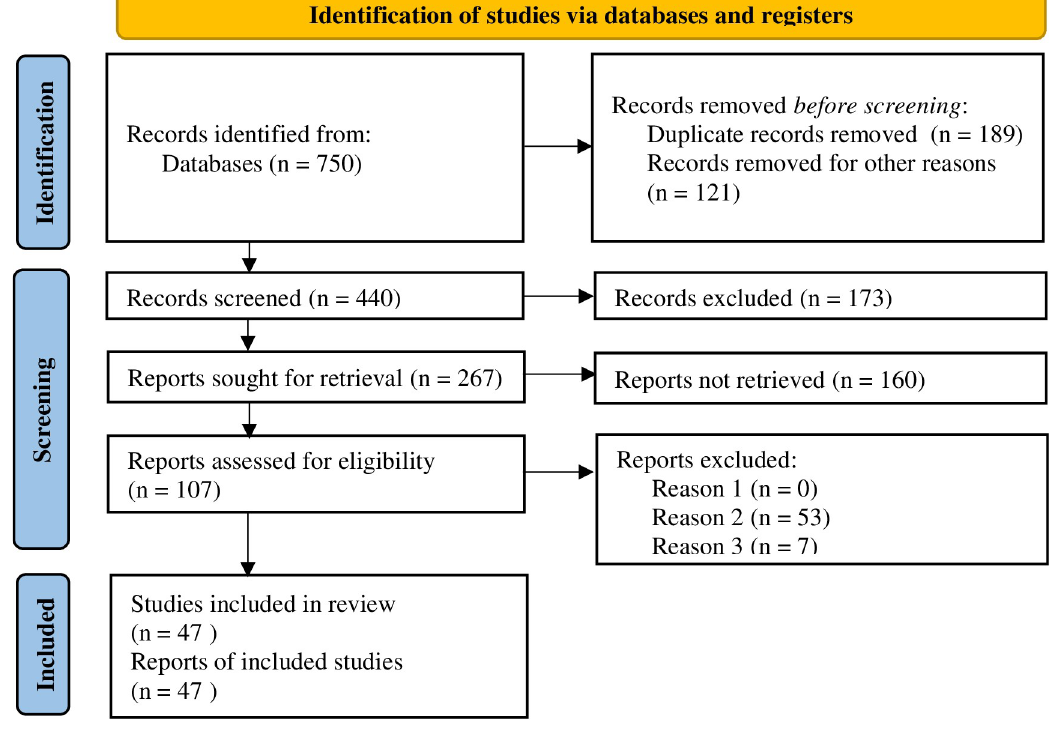
Fig 1. Publication selections. Source: PRISMA 2020 flow diagram [109].